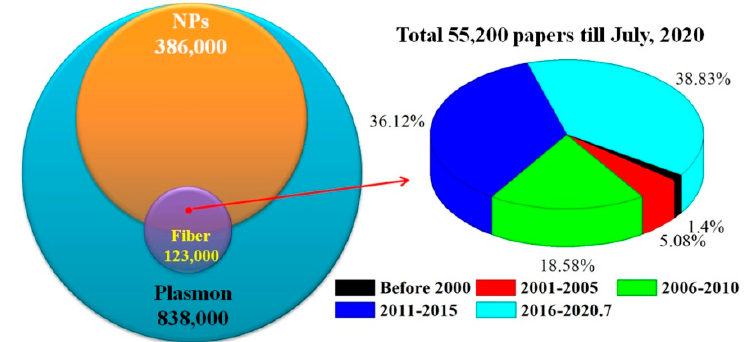
ff erent key words and interval